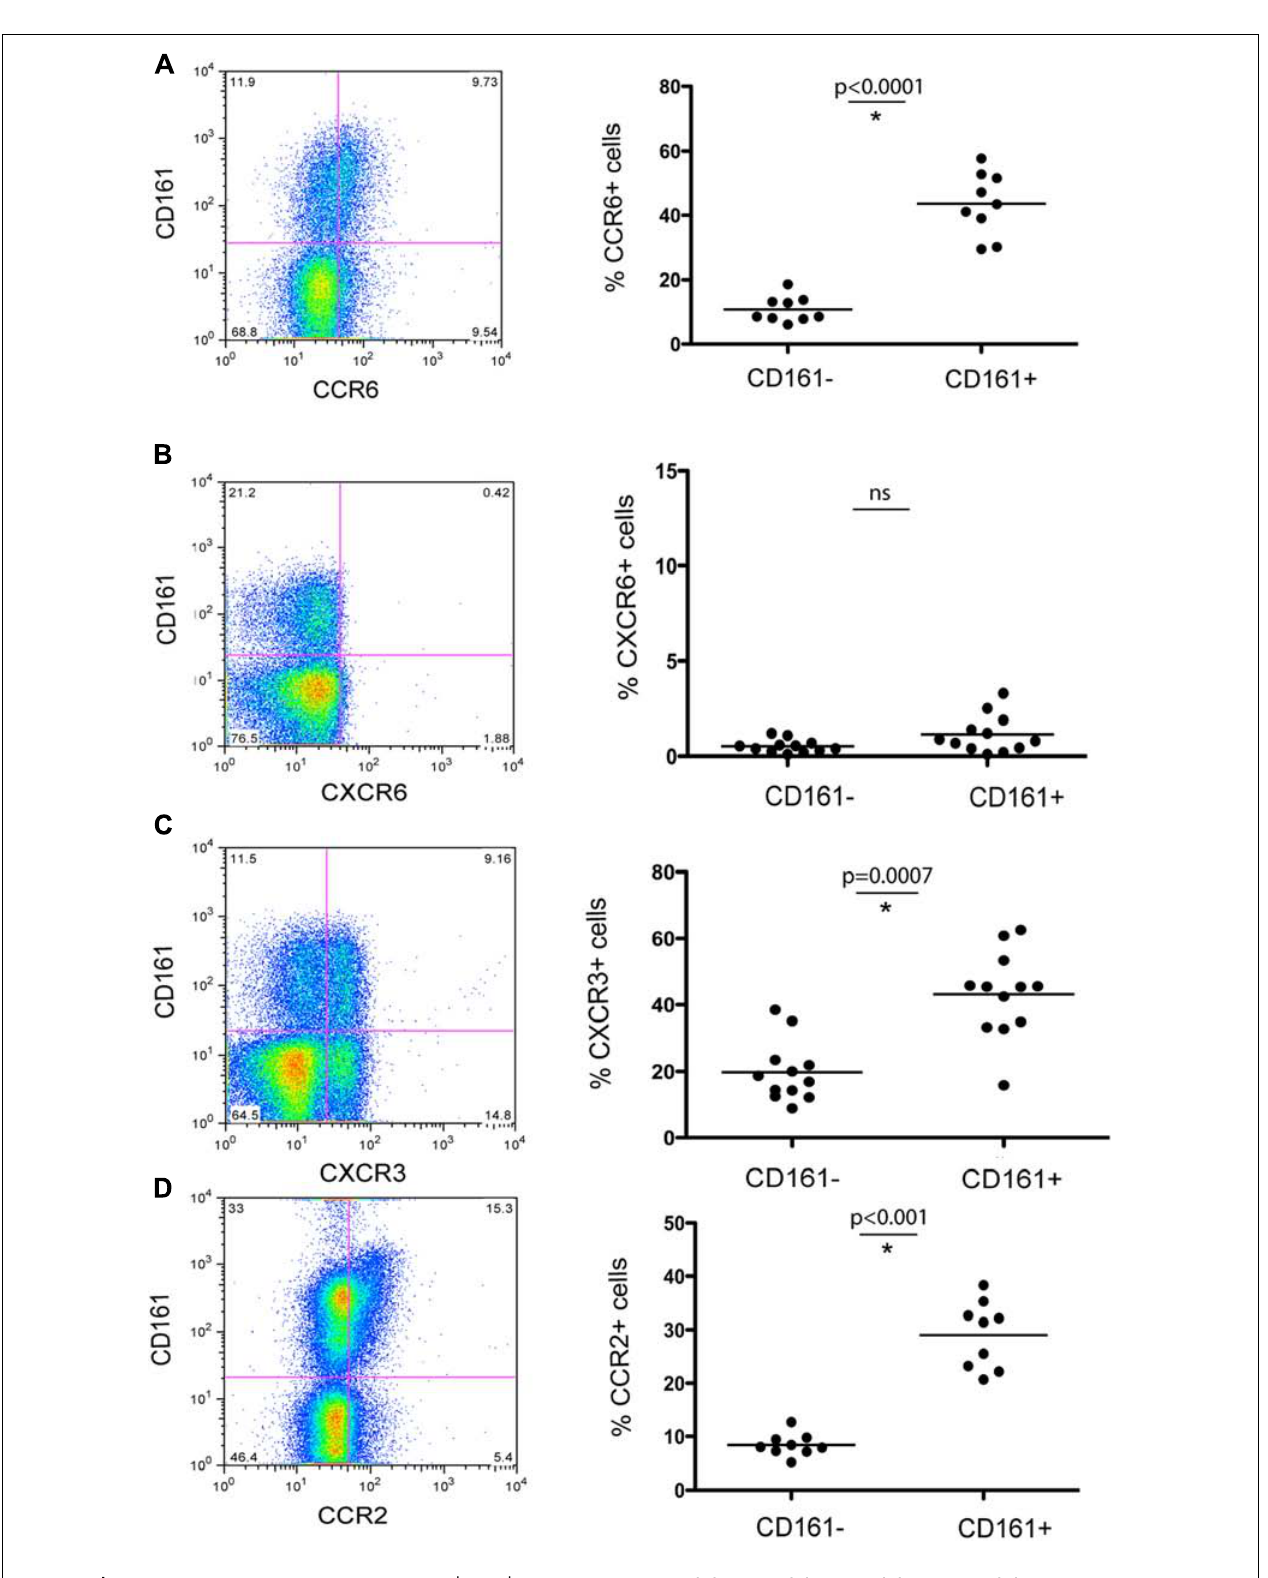
CCR6 (A) , CXCR6 (B) , CXCR3 (C) , and CCR2 (D) . Plots show gated live CD3 + CD4 + lymphocytes. In each case an example is shown on the left and group data on the right, with comparison by Mann–Whitney